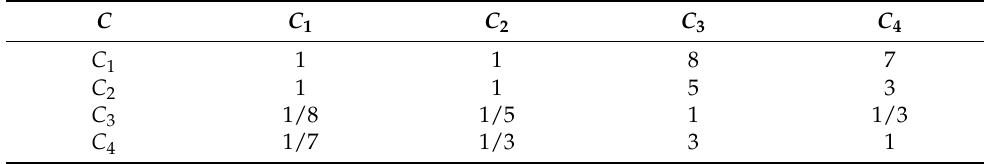
Table 9. Judgment matrix of shotcrete material indicators.